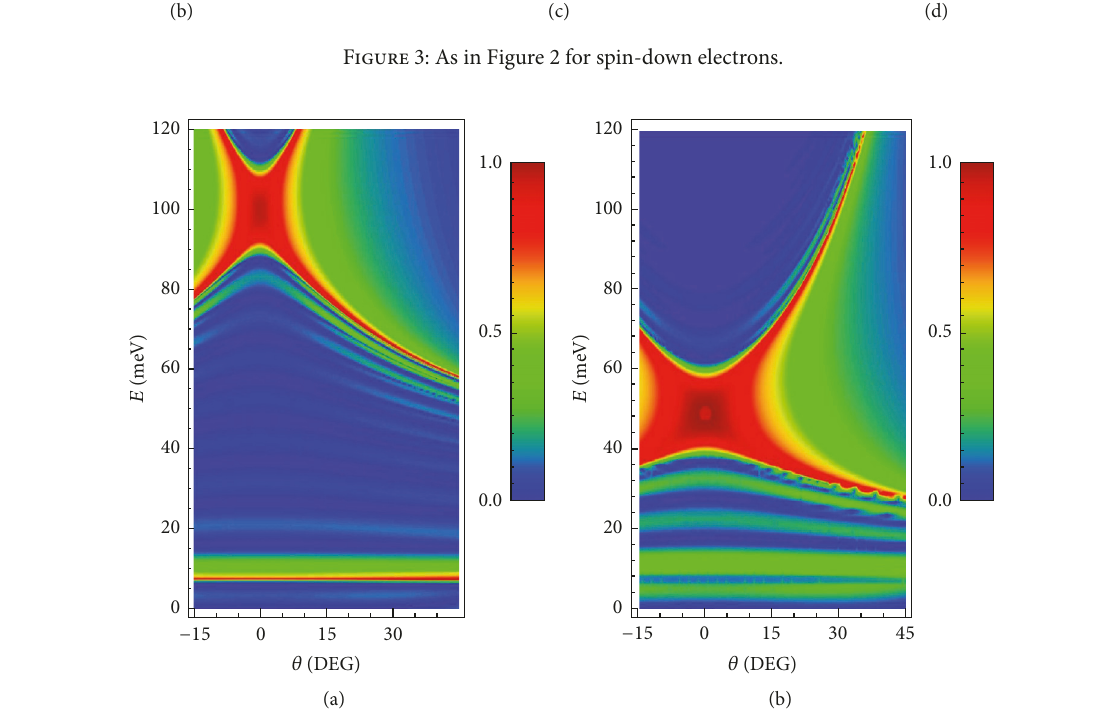
shown, the most important change is that the “red” window in (a), centred at 𝜃 = 0 , 𝑈 = 100 meV, is now centred at 𝜃 = 0 , 𝑈 = 50 meV, and nearly twice as